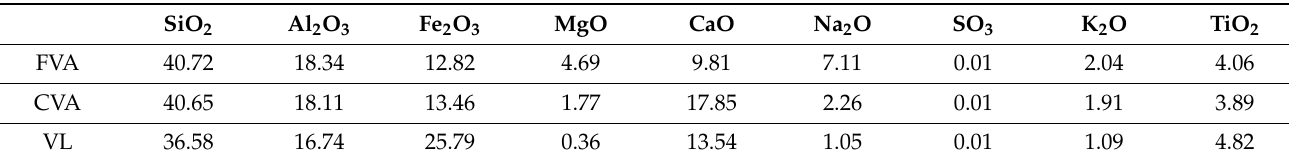
Table 4. Chemical composition of volcanic materials performed by energy dispersive spectroscopy determines the (wt%).